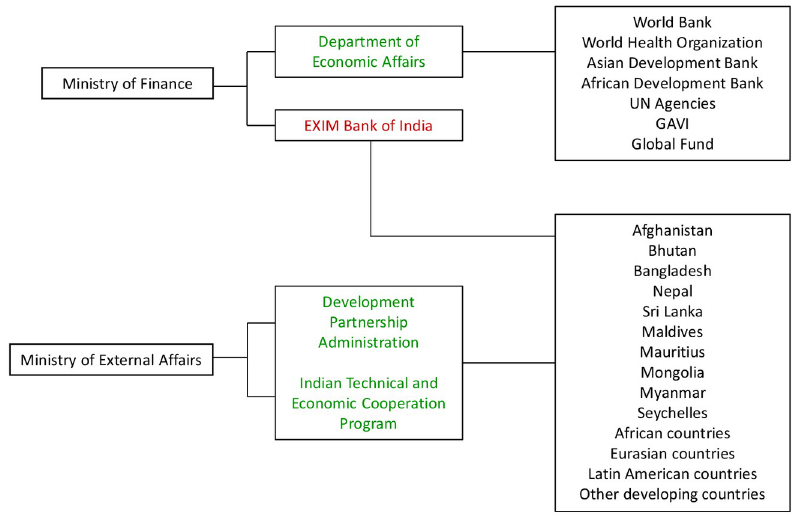
Fig 1. Framework of India DAH dissemination. Note: Green indicates data that have been included in our estimation of DAH, whereas red indicates data that have not been included due to limited availability.